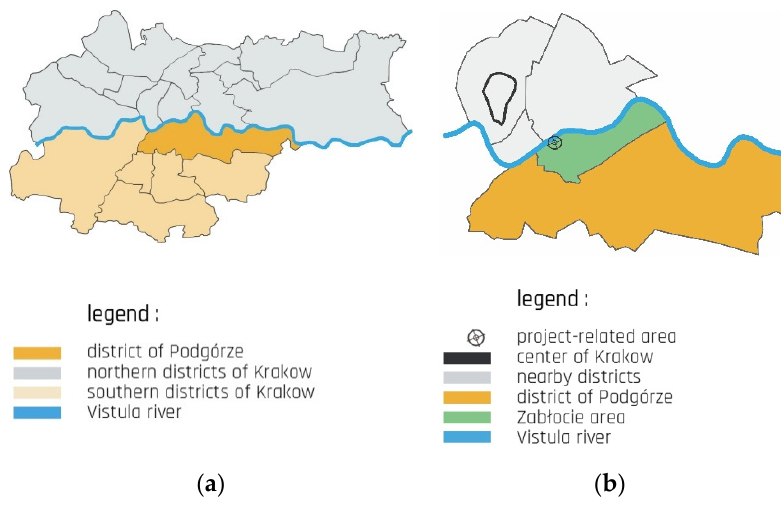
Figure 1. Diagrams showing the location of the project-related area: ( a ) Podgórze district area in the context of other Cracow districts; ( b ) Zabłocie area within the scope of Podgórze district and in proximity of the Old Town [2] (elaborated by E. Latusek).